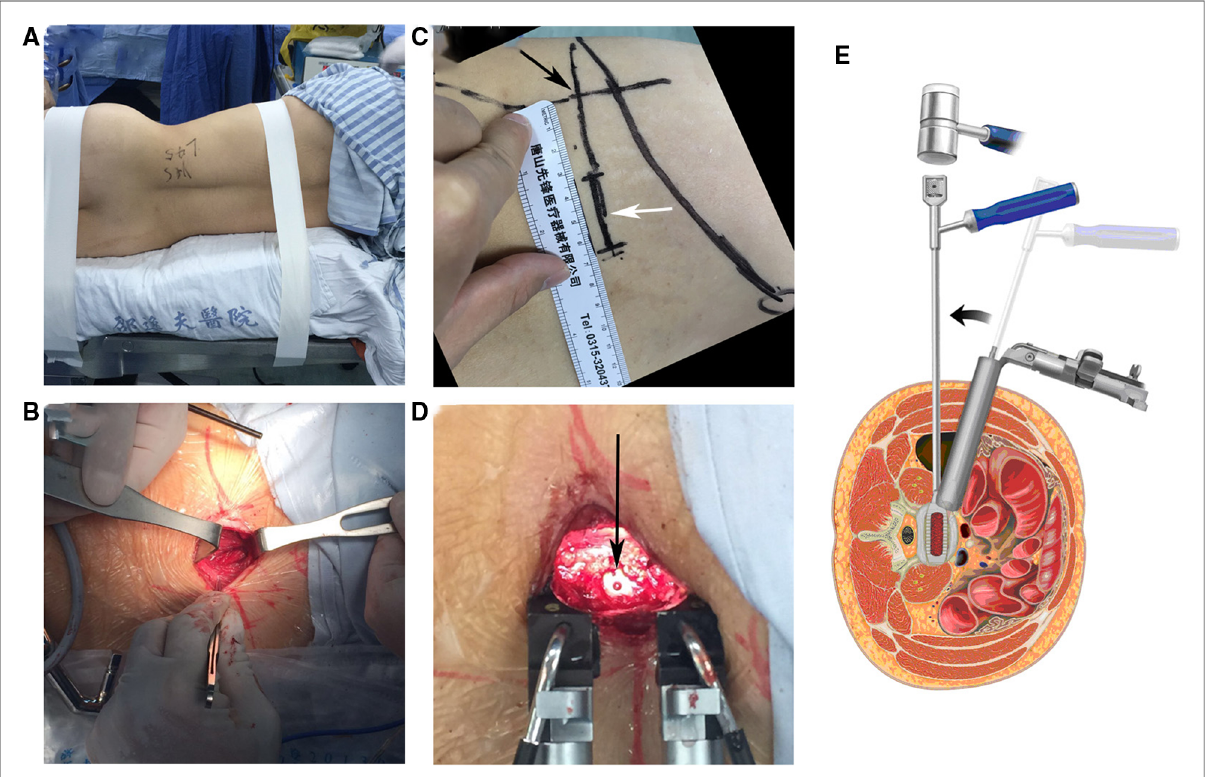
FIGURE 2 OLIF procedure ( A ) OLIF position: right side prone position. ( B ) OLIF incision: preoperative fl uoroscopic localization of the center of the target disc (black arrow), about 3-4 cm anterior to the midpoint of the target disc and 4 cm in length (white arrow). ( C ) Sequential separation of the abdominal muscles in the direction of the muscle fi bers. ( D ) After completion of cage (arrow) implantation. ( E ) Schematic diagram of the transverse OLIF approach and